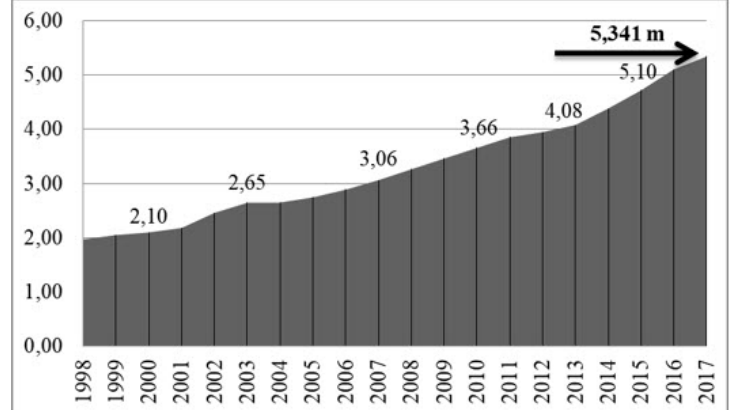
Figure 1. The number of international students in 1998-2017, million